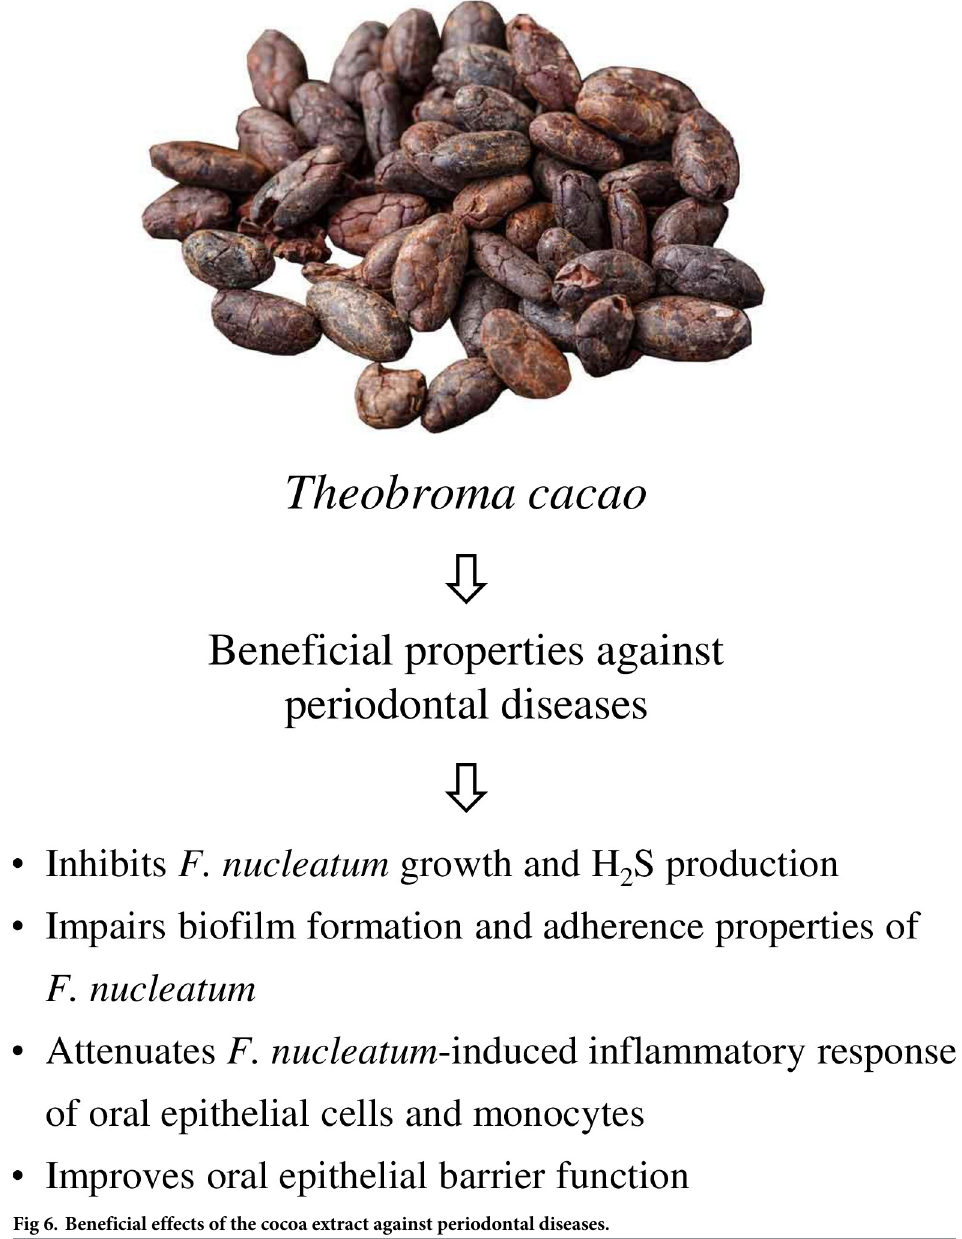
Fig 6. Beneficial effects of the cocoa extract against periodontal